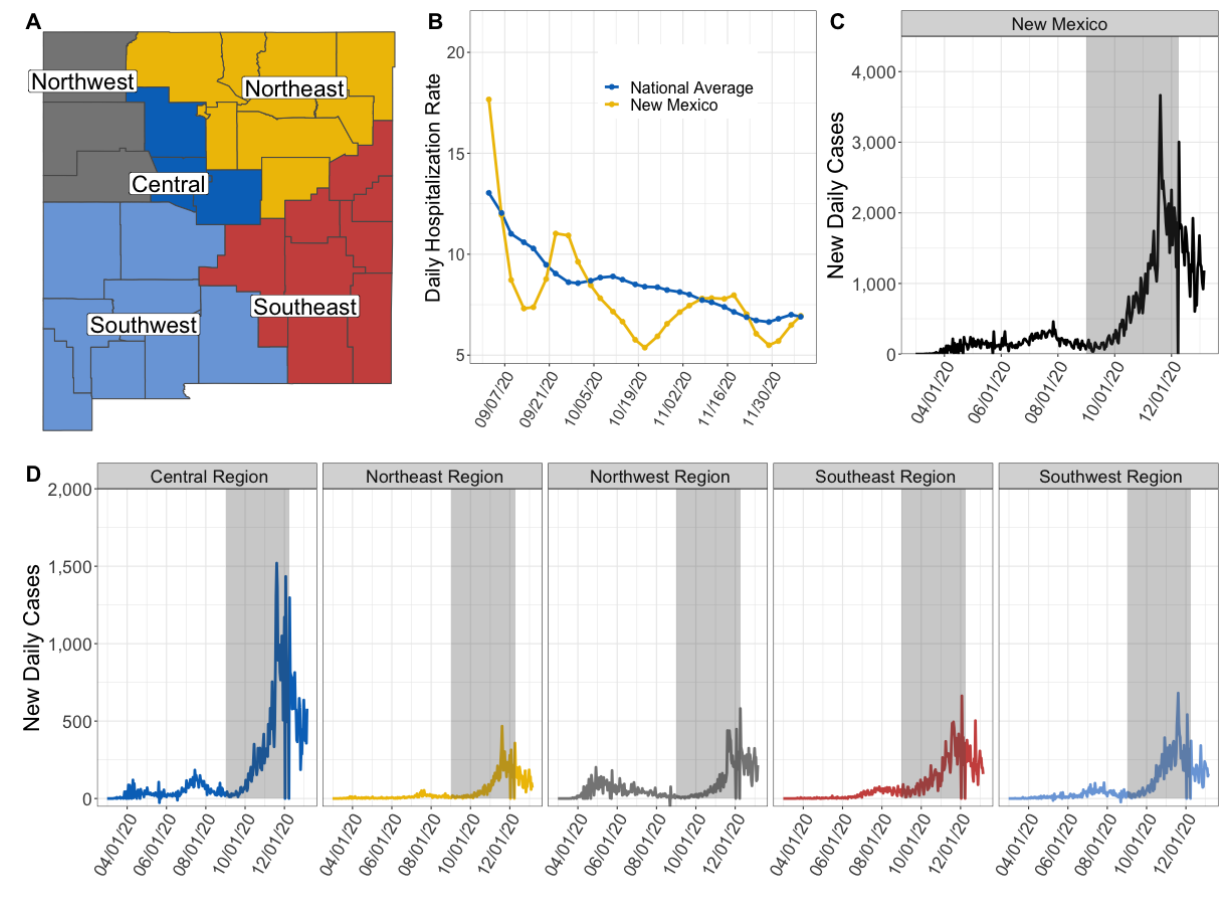
Figure 1. New Mexico health regions, COVID-19 confirmed case time series from March 2020 to January 2021, and daily hospitalization rates from September to December 2020. (A) Division of New Mexico’s 33 counties into five health regions. (B) The 2-week weighted daily hospitalization rate for New Mexico (yellow) compared to the national average (blue) (C). The number of new daily cases at the state level, with the grey box denoting the period of forecast performance evaluation. (D) The number of new daily COVID-19 cases for each of the five